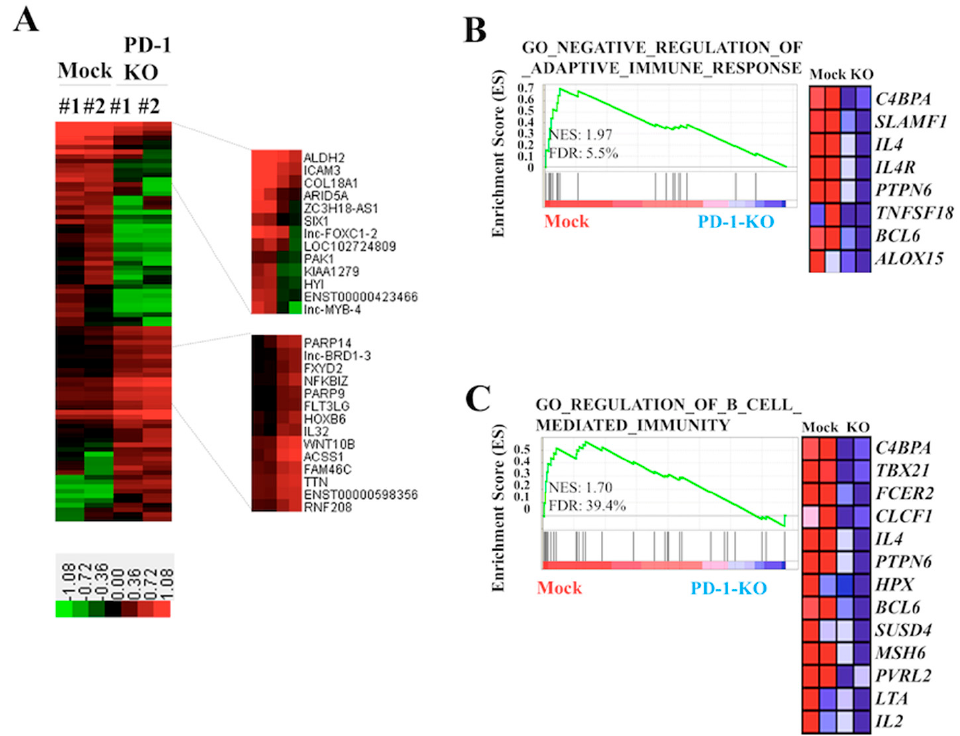
Figure 4. Gene expression analysis between VAL/mock and VAL/PD-1-KO cells. ( A ) Heat map of the top 86 upregulated and downregulated genes in VAL/PD-1-KO cells. The heat map, with the corresponding gene name on the right side, was constructed using GSEA version 2.2.4 software (Broad Institute). ( B , C ) Representative GSEA enrichment plots and corresponding heat maps of the indicated gene sets in VAL/mock and VAL/PD-1-KO cell clones. ( B ) Negative regulation of adaptive immune response signaling. ( C ) Regulation of B-cell-mediated immunity. Genes contributing to enrichment are shown in rows, and the sample is shown in one column on the heat map. Expression is represented as a gradient from high (red) to low (blue). FDR, false discovery rate; NES, normalized enrichment score.